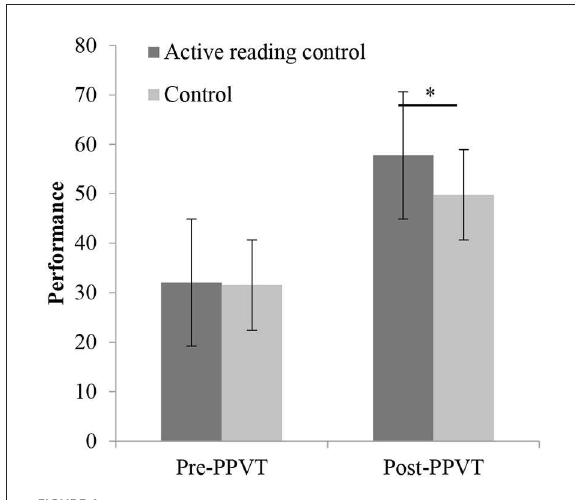
FIGURE4 PPVT pre- and post-performance between active reading control group and control group. PPVT, receptive vocabulary skills, * p < 0.05.